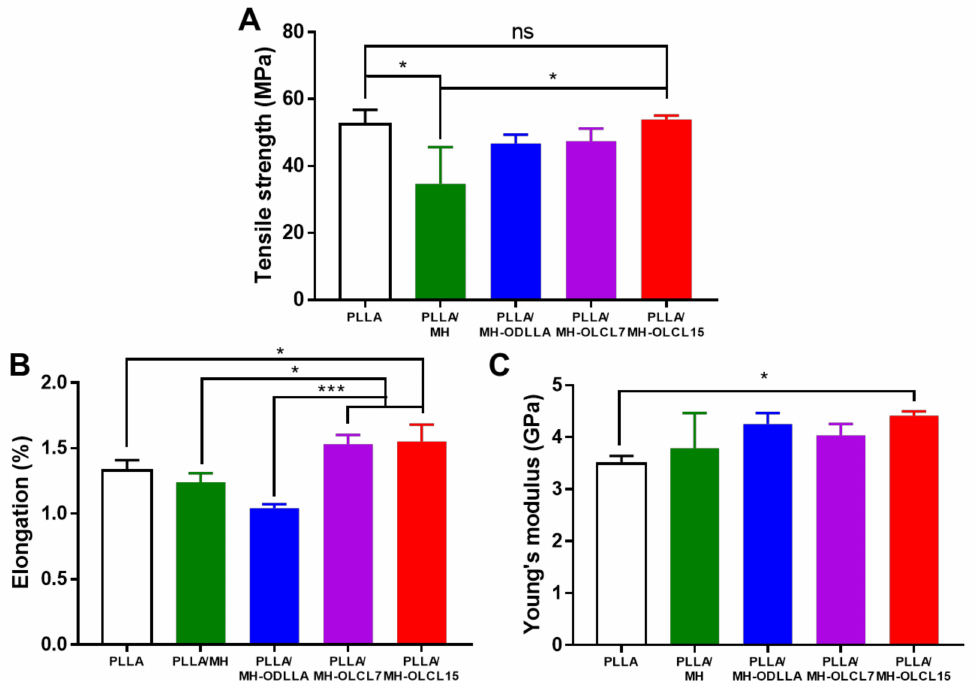
Figure 4. Mechanical properties of the PLLA, PLLA/MH, PLLA/MH-OLCL7, and PLLA/MH-OLCL15. ( A ) tensile strength, ( B ) elongation, and ( C ) Young’s modulus (* p < 0.05, ** p < 0.01, and *** p <